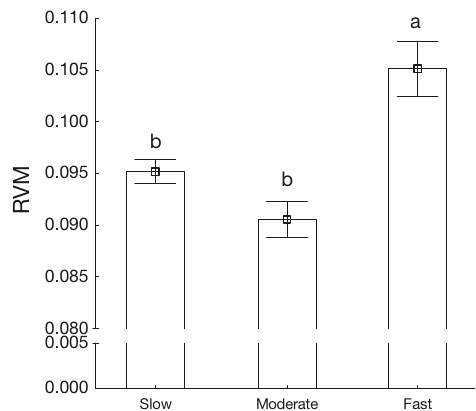
Fig. 2. Relative ventricular mass (RVM, mean ± SE) in At- lantic salmon Salmo salar in slow, moderate and fast velocity groups (see Table 1) at the end of the experiment. Signifi- cant differences between groups (p < 0.05) are